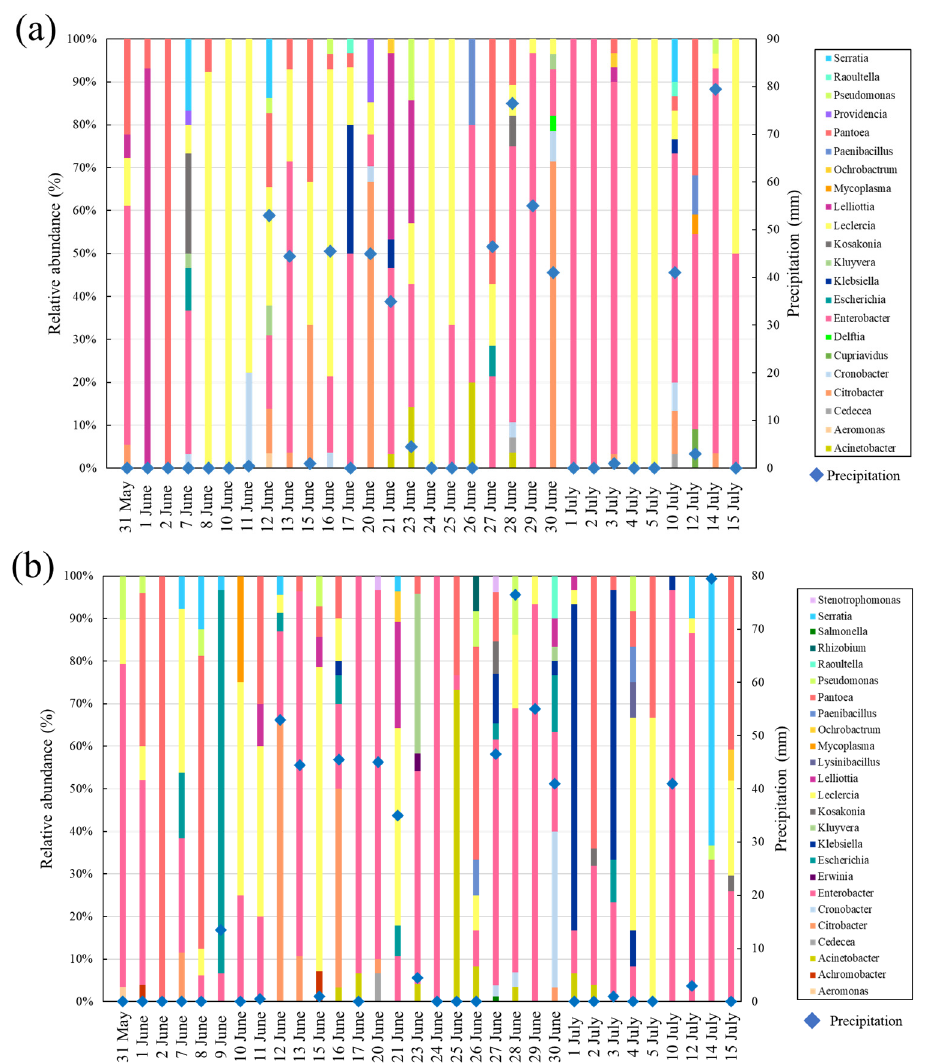
Figure 4. ( a ) Analysis of coliforms in supratidal top surface sand at Kizaki Beach. ( b ) Analysis of coliforms in supratidal top surface sand at Shirahama Beach.